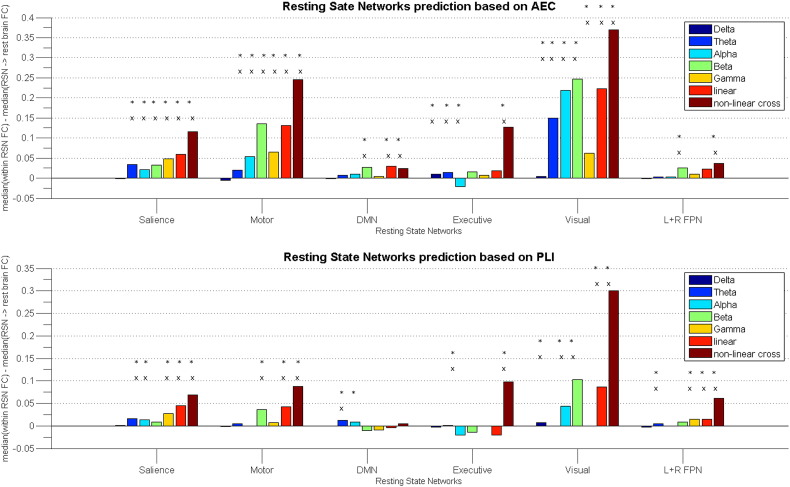
Estimated parameters (Taylor coefficients) for analysis level 1 using model e, linear + non-linear approximation based on all MEG frequency bands using the PLI and AEC as functional connectivity metrics for MEG. Note the smaller confidence intervals compared to Fig. B6, but also note that confidence intervals increase for increasing higher order terms.